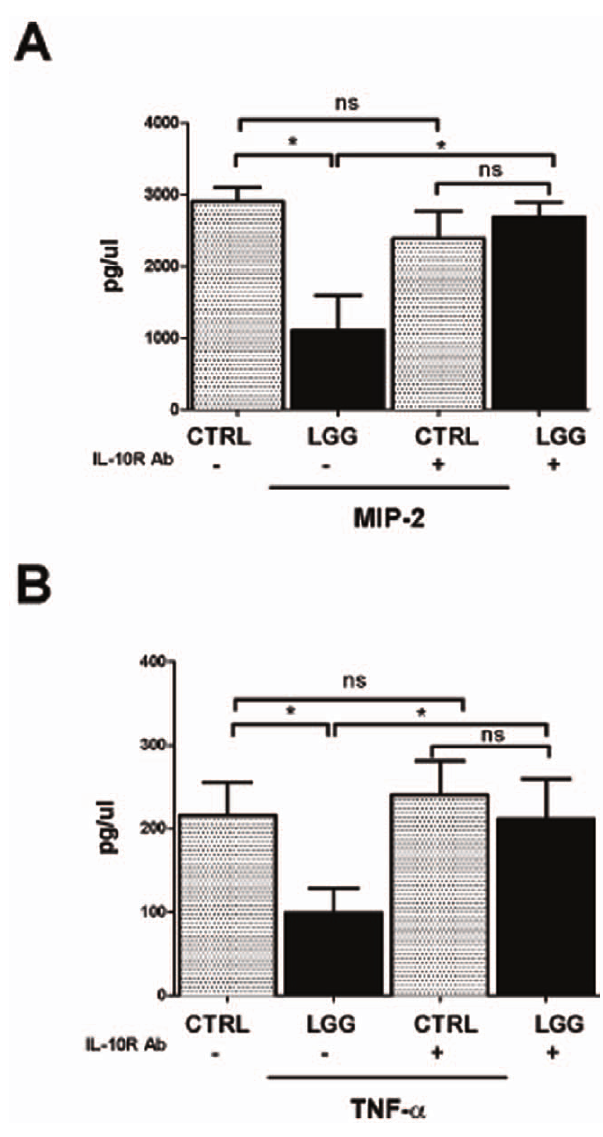
Figure 5. LGG mediated suppression of MIP-2 and TNF- a expression in the developing murine colon is dependent on the IL-10 receptor. 2 week-old mice were treated by intraperitoneal injection with either 200 m g IL-10R Ab, or an isotype-matched control Ab, immediately prior to gavage feeding with 10 8 CFUs LGG or vehicle alone. 24 hours after treatment, colonic supernatants were collected and assayed for MIP-2 (A) and TNF- a (B) by ELISA. Data are depicted as mean 6 SEM (n=3 separate experiments, for a total of 7 mice per condition, *p , 0.05).